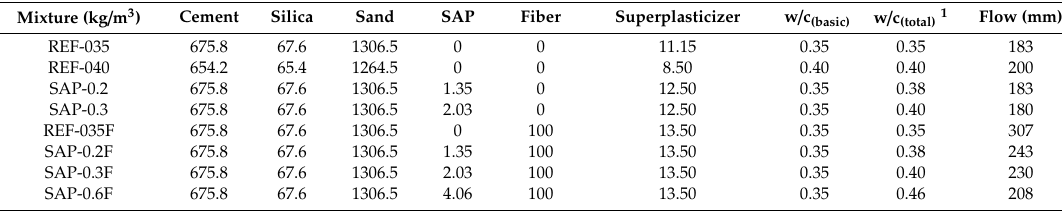
Table 2. Composition of the concrete mixtures, values in kg / m 3